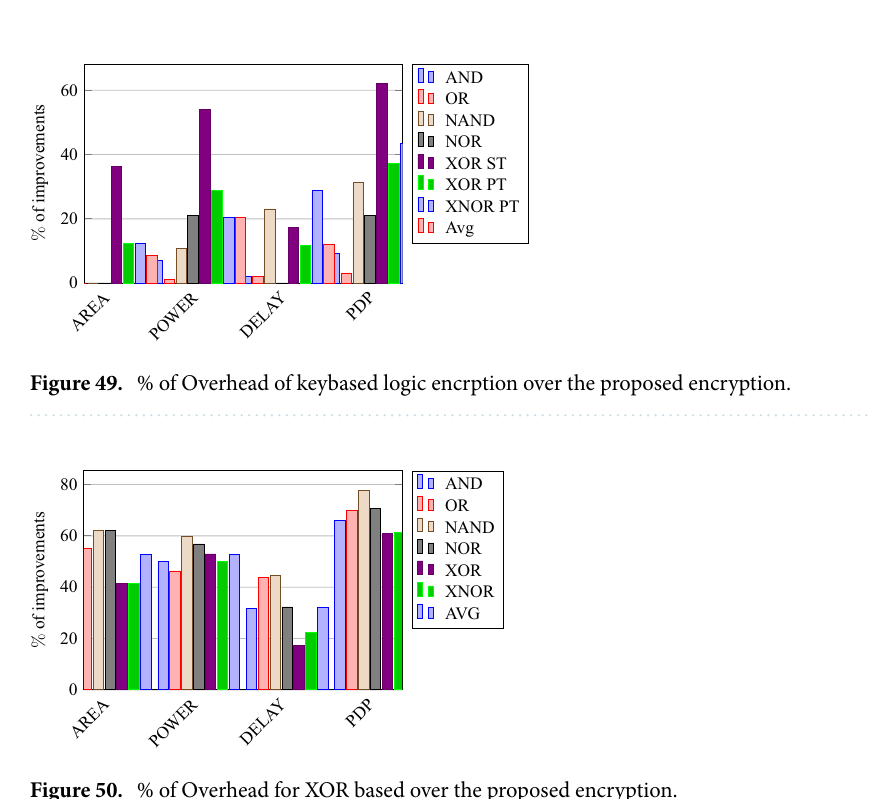
Figure 50. % of Overhead for XOR based over the proposed